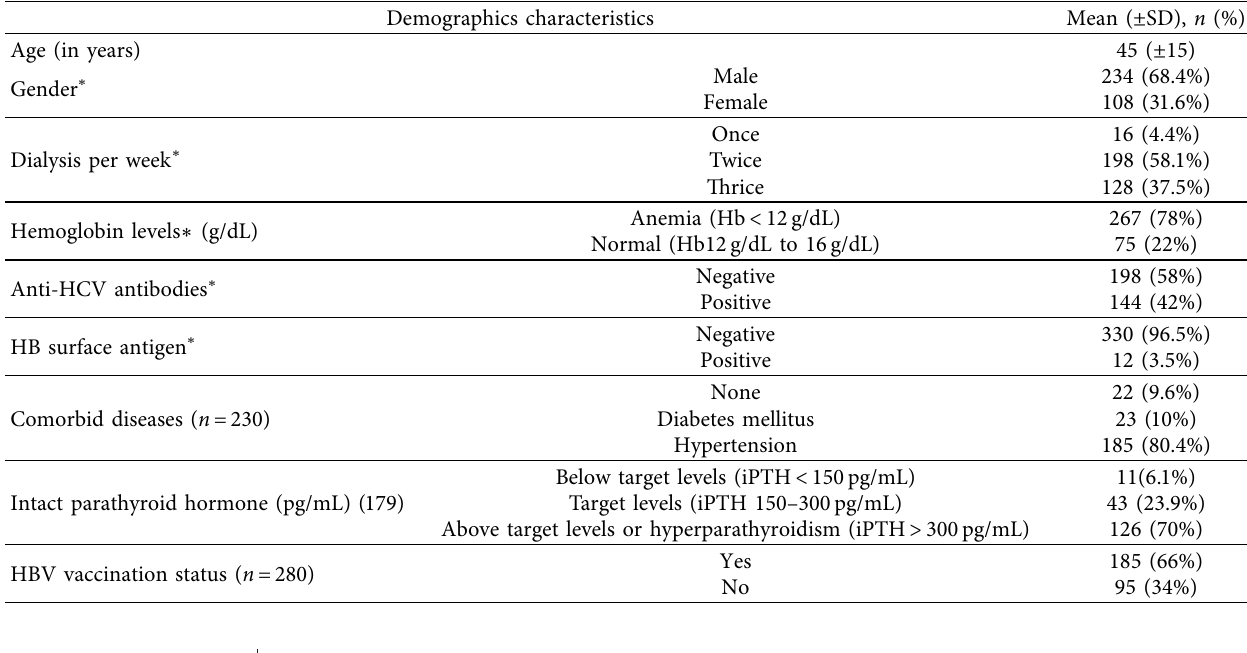
Table 1: Demographic characteristics of patients ( n � 342) ∗